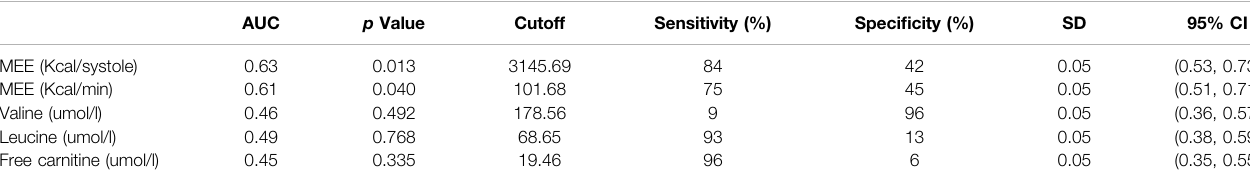
TABLE 5 | The comparison of area under ROC curve of MEE and metabolomics.